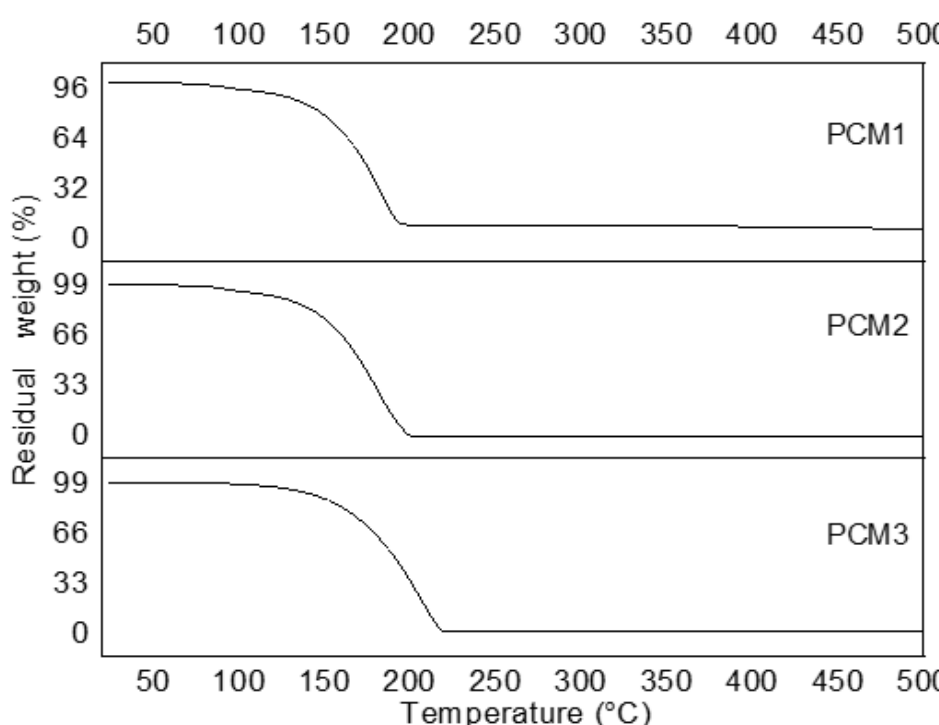
Figure 1. TGA curves of the PCM1-3.